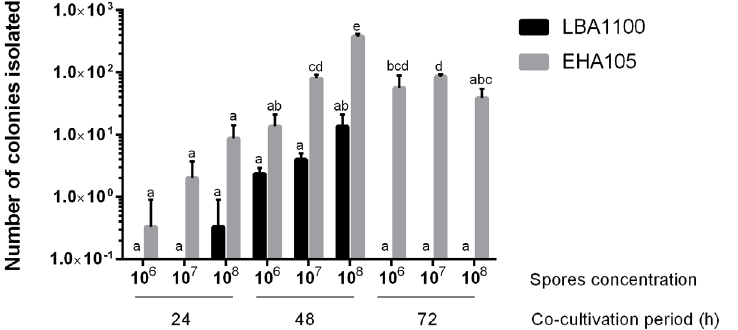
Figure 2 ‒ Transformation efficiency. To determine the most suitable transformation protocol for S. subtropicum , different strains of A. tumefaciens were evaluated (EHA105 and LBA1100), as well as different spore concentrations (1 x 10 6 , 1 x 10 7 , or 1 x 10 8 spores/mL) and co-cultivation times (24, 48, and 72 h). The different letters above bars indicate statistical differences between transformation regimes according to one-way ANOVA analysis followed by posthoc Tukey’s test ( p < 0.01).